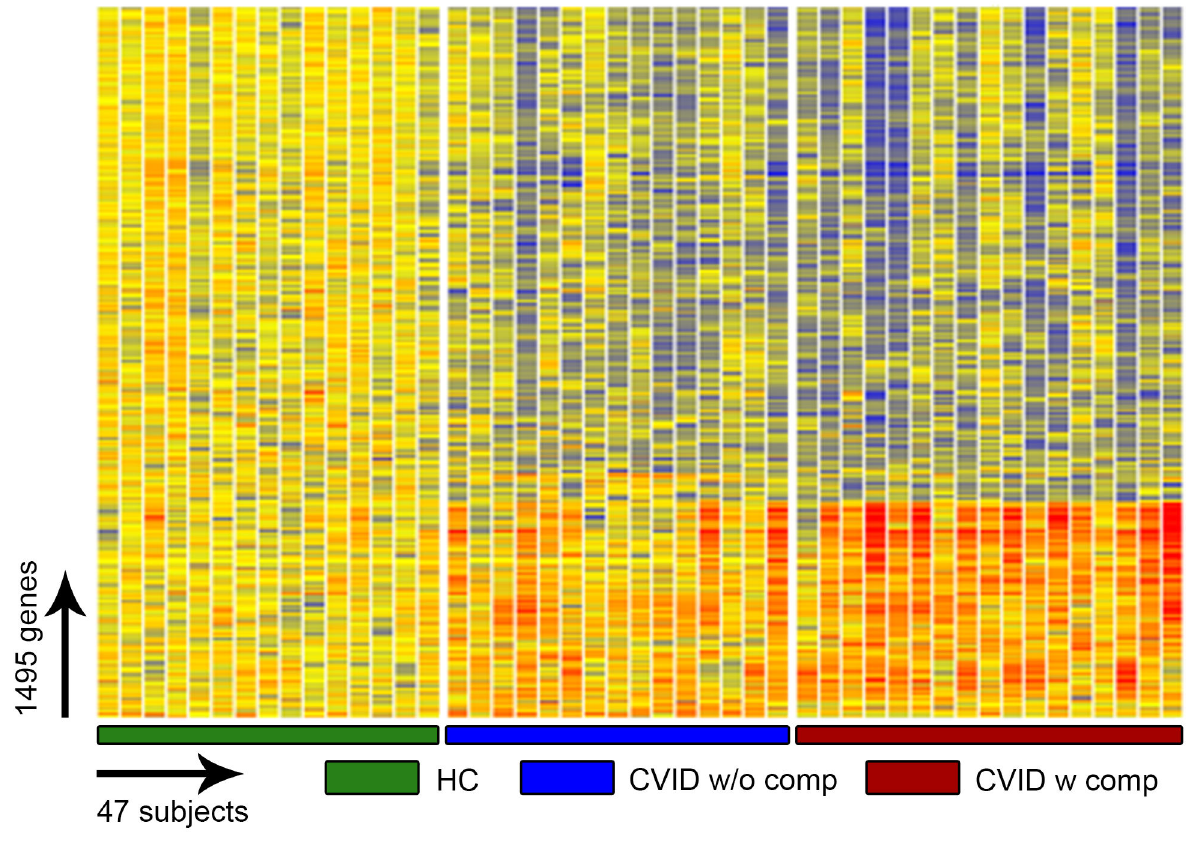
Figure 5. ANOVA test (FDR 0.05) comparing CVID blood (test set) healthy controls. This test identified 1495 transcripts differentially expressed in the blood of CVID patients, identified here with and without inflammatory complications and healthy